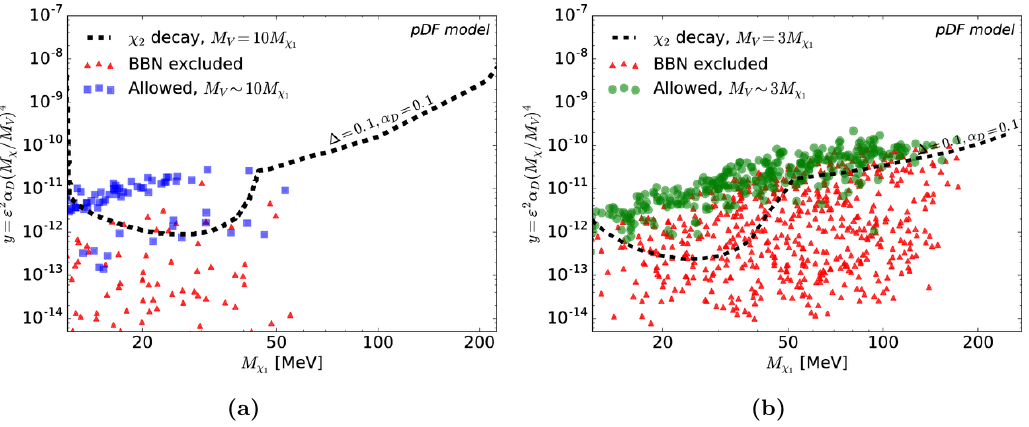
Figure 7. An example of bounds on the parameter y mass M (cid:31) for (cid:1) 0 : 1 ; (cid:11) D 0 : 1 from [56]. We show the points from our scans satisfying all our (cid:24) (cid:24) constraints as well as (cid:1) < 0 : 1 ; (cid:11) D < 0 : 1 and M V bound is weaker for smaller (cid:1) and (cid:11) D , the represented lines are the strongest possible bounds